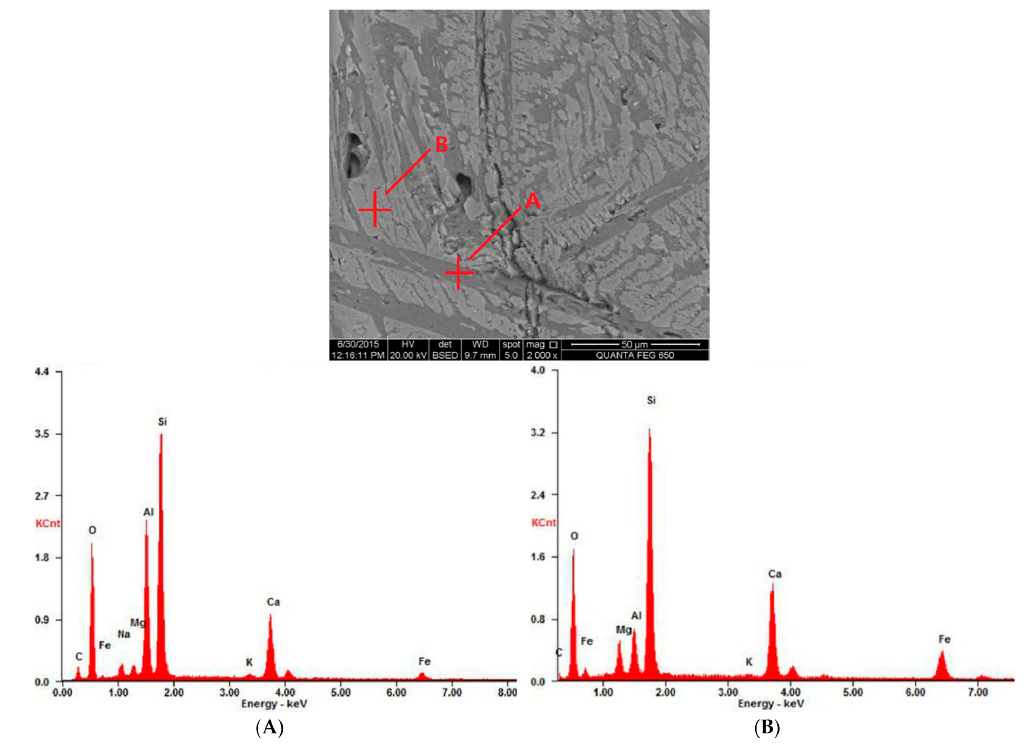
Figure 13. Scanning electron microscope and energy-dispersive spectrometer (SEM-EDS) analysis of minerals in 80%-O 2 slag. ( A ) Anorthite crystals; ( B ) Solid solution of gehlenite and